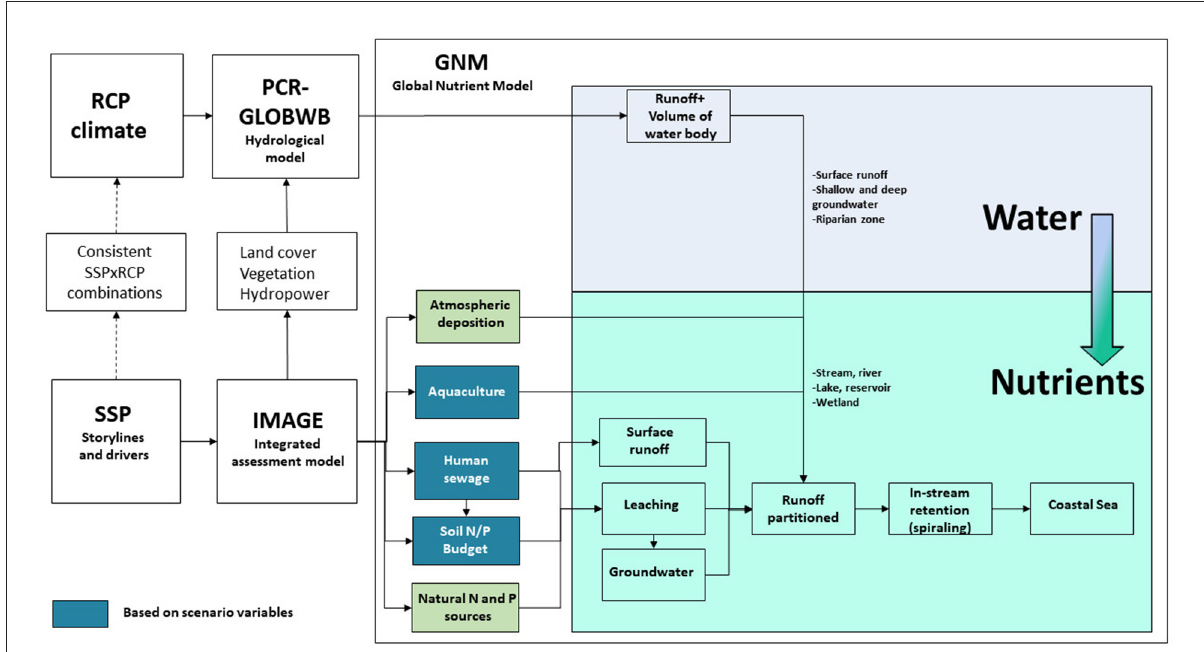
FIGURE1 Scheme of the Integrated Model to Assess the Global Environment (IMAGE) – Global Nutrient Model (GNM), including the PCR-GLOBWB model to describe the hydrology. The human (sewage), aquaculture and soil N/P budget boxes indicate where scenario assumptions are used to express the N and P scenario storylines in quantitative